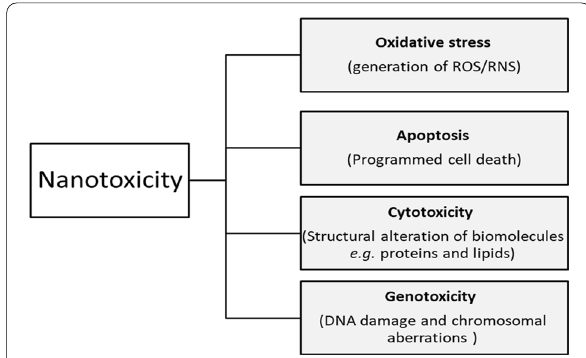
Fig. 3 Schematic illustration demonstrates the consequences of nanotoxicity. NPs-correlated toxicity could result in oxidative stress caused by ROS generation, apoptosis, cytotoxicity, and genotoxicity. The anti-viral potential of NPs might be ascribed to these nanotoxicity-associated mechanisms, through enhancing mitochondrial-apoptotic pathways. In case of non-selective toxicity, these mechanism might cause damage to the mammalian cells